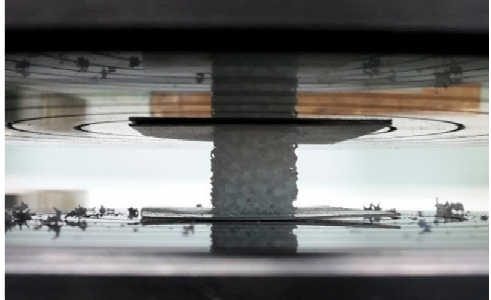
Figure 1. Setup of the compressive strength measurement. The cardboard placed on top and underneath the specimen is